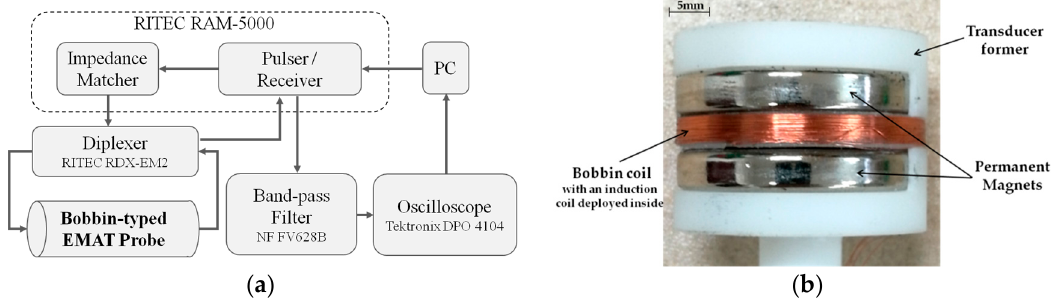
Figure 10. Experimental setup: ( a ) Schematic illustration; and ( b ) picture of the fabricated transducer.